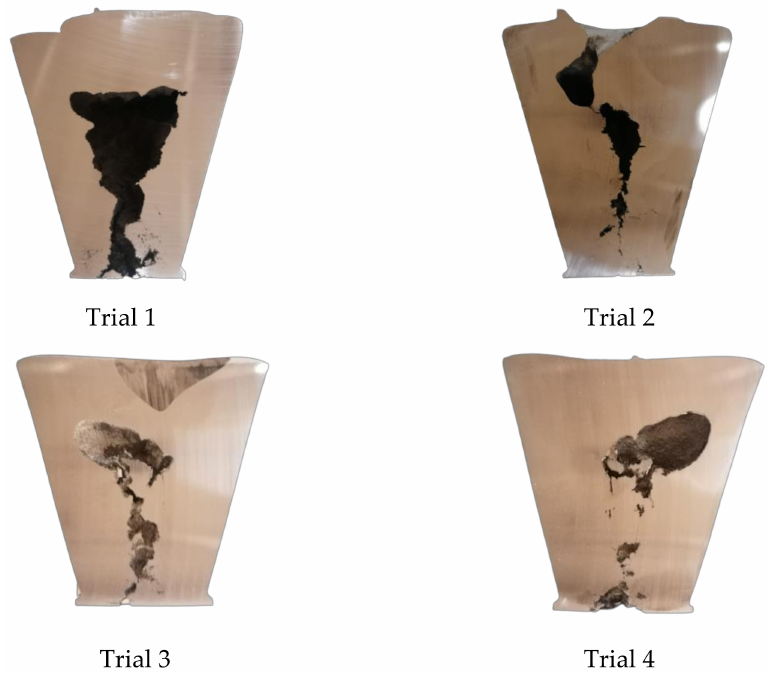
Figure 19. Visual inspection of the gating system, trial 1 to 4 (cross-section